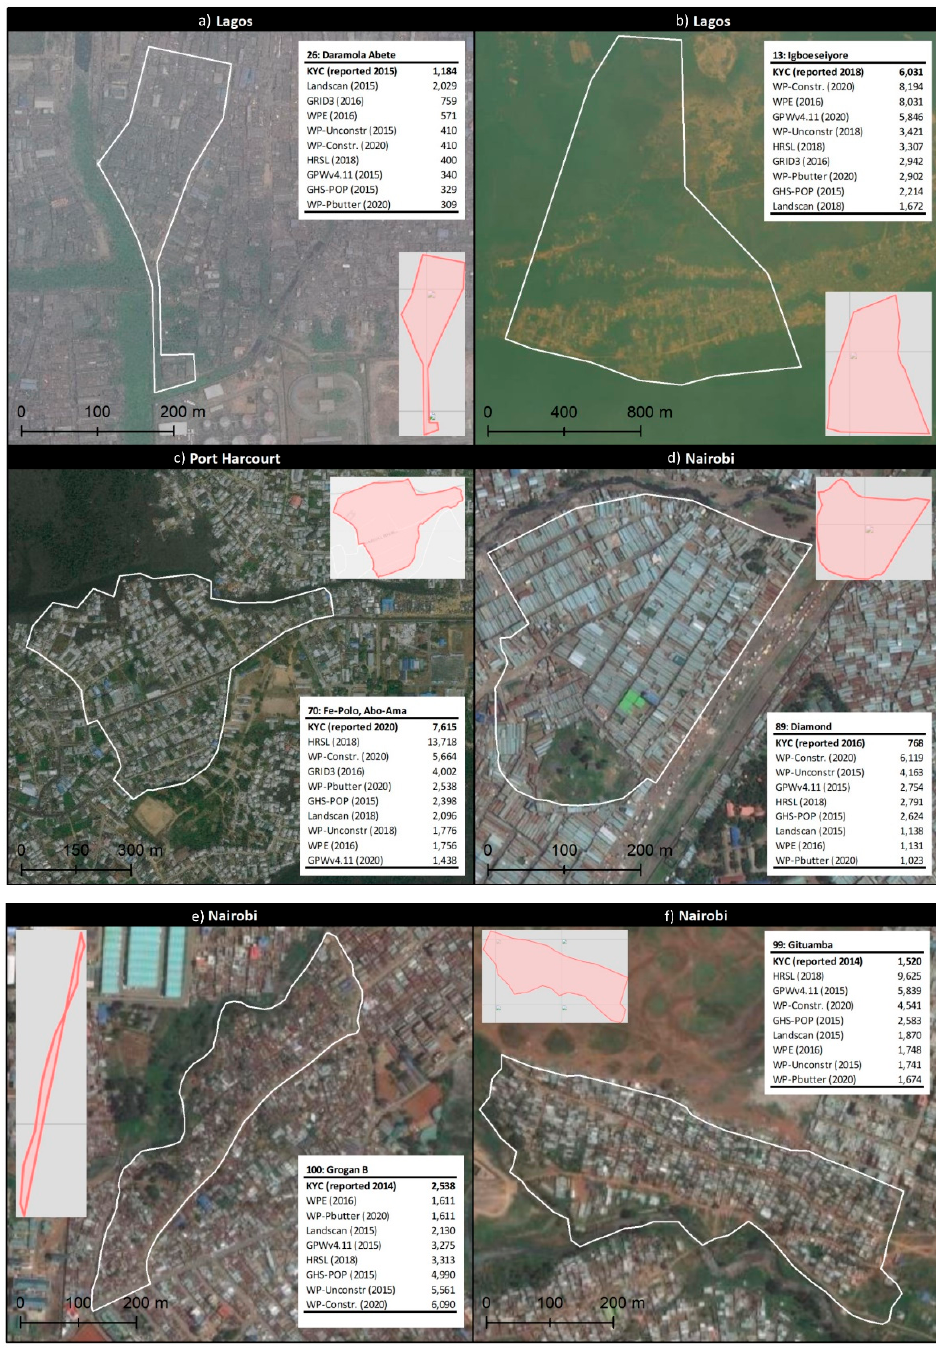
Figure A6. Comparison of gridded population estimates and KYC reported population in select settlements with at least one sizable gridded population overestimate for ( a , b ) Lagos, ( c ) Port Harcourt, and ( d – f ) Nairobi.